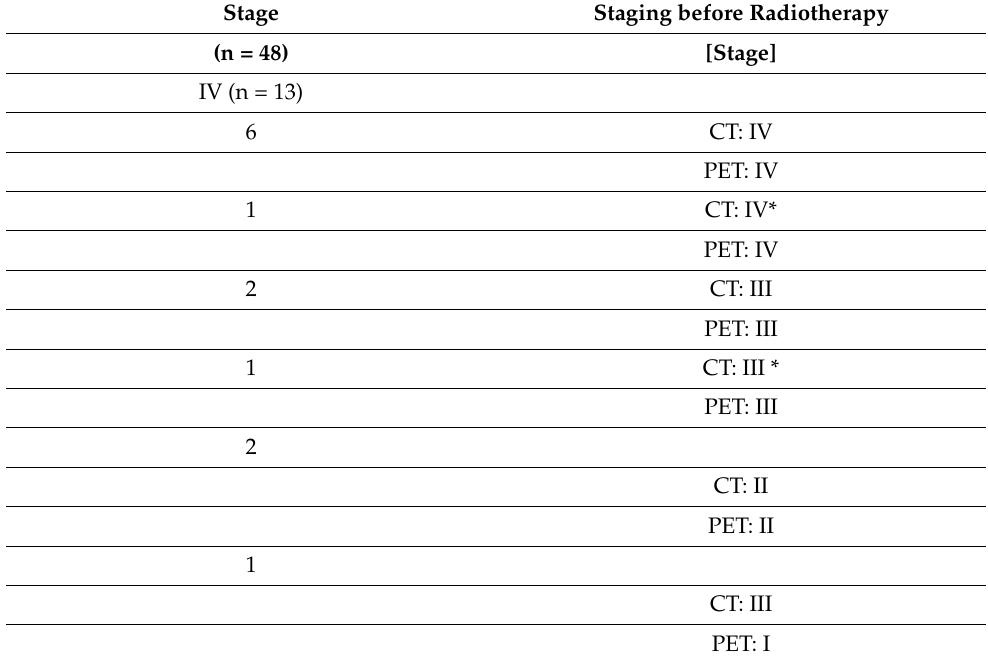
Table 5. Cont. Stage Staging before